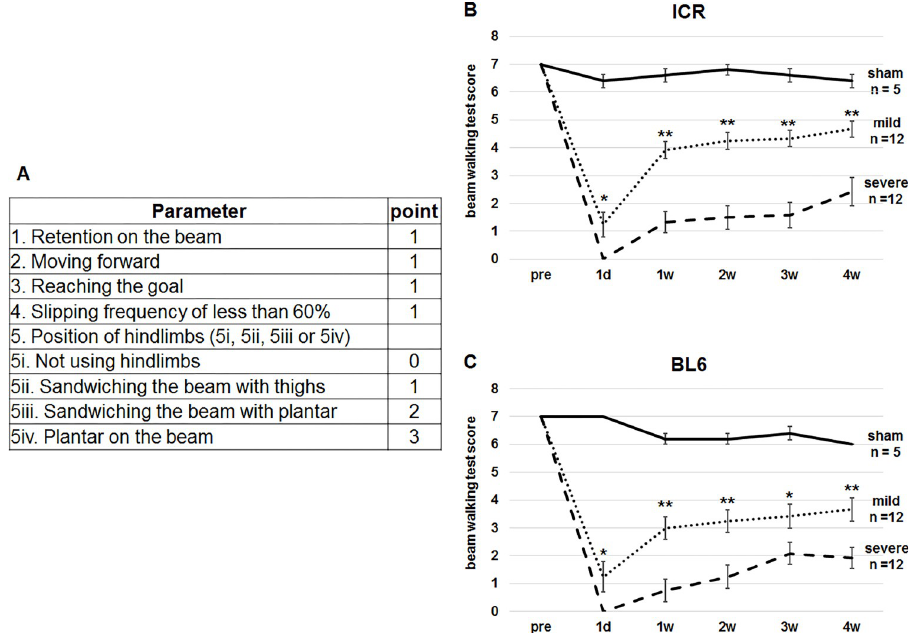
Fig 6. Beam-walking test scoring protocol. (A) The scoring protocol. One point each was given when the mice retained on the beam, moved forward, reached the goal and slipped with frequency of less than 60%. Regarding the appearance of hindlimbs on the beam, 0, 1, 2 or 3 points was given to mice which could not use hindlimbs, those which sandwiched the beam from the both sides with thighs, those which sandwiched the beam from the both sides with plantar and those which put plantar on top of the beam, respectively. Therefore, the total points ranges from 0 to 7. (B, C) The scores of ICR (B) and C57BL/6 (C) mice were compared between mild SCI and severe SCI 1 day (d), and 1, 2, 3 and 4 weeks (w) after SCI. Mann-Whitney U test was used to compare the score at each time point. � p < 0.05, �� p < 0.01.